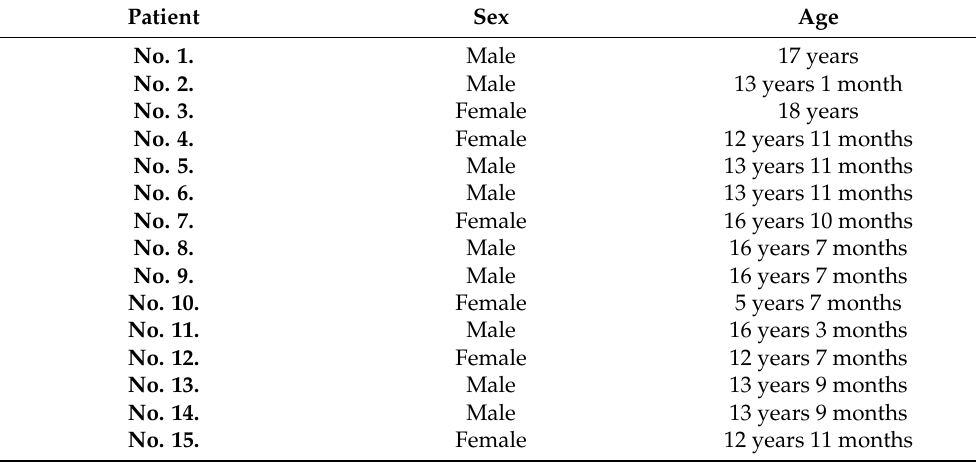
Table 1. Information about the first-time surgery CLP